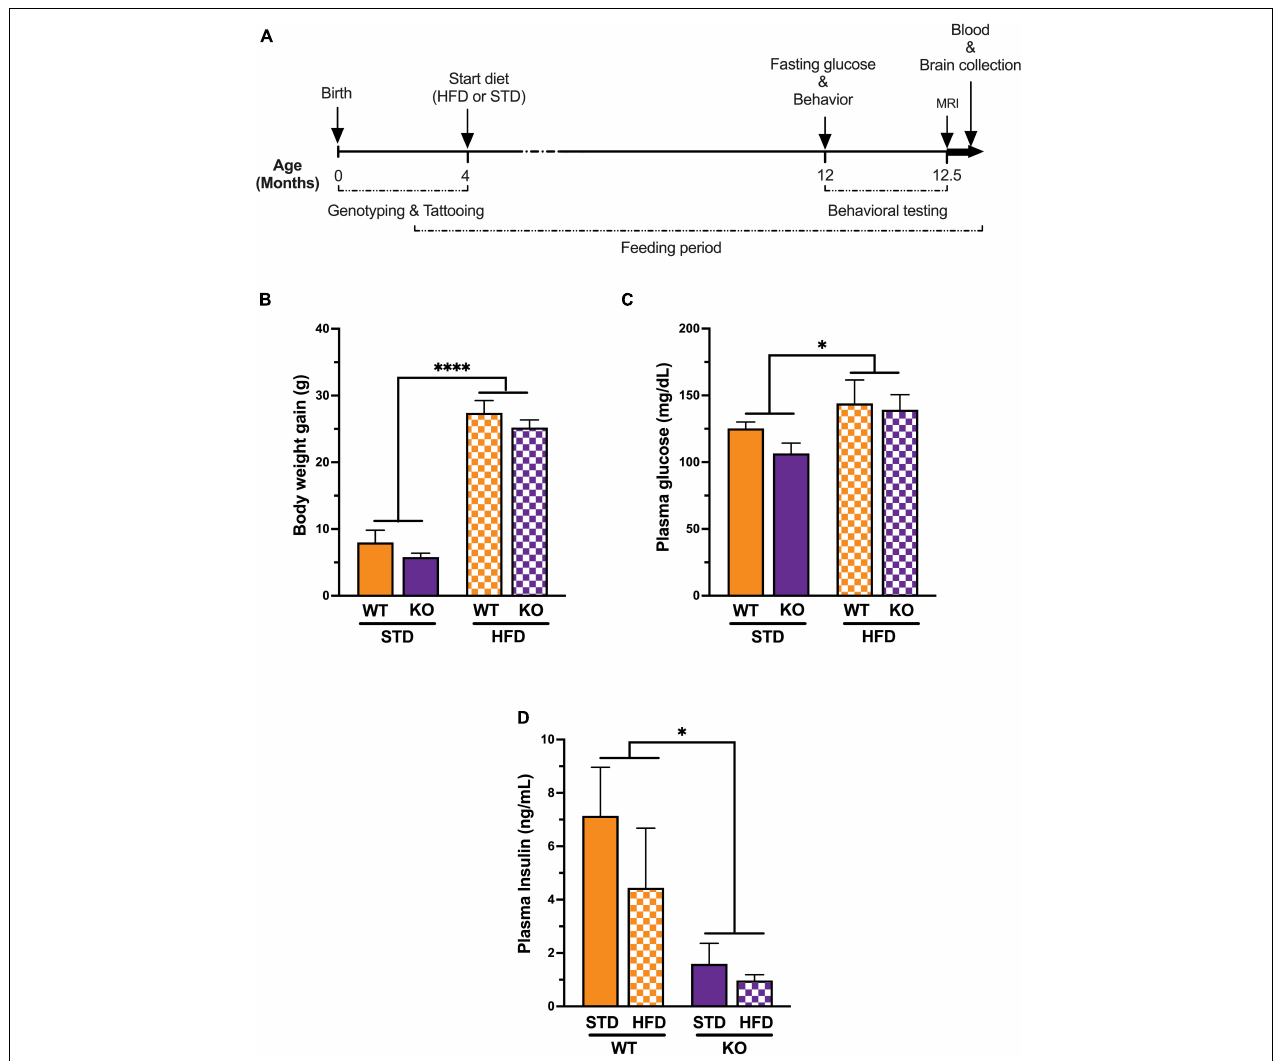
FIGURE 1 | Experimental timeline and Impact of high fat diet on metabolic syndrome. (A) All genotypes of mice were placed on a high fat diet or standard diet at 3–5 months of age. Behavioral and cognitive performance was assessed using the water maze and the novel object recognition tests. Fasting glucose was measured just before behavior and magnetic resonance imaging ( n = 6 per group, randomly selected) upon completion of the study. Plasma samples and brains were collected for biochemical assays and oxylipins analysis respectively. (B) Mice on a long-term high fat diet develop a diabetic phenotype. Prior to initiation of dietary intervention, there were no significant difference in body weight between groups. High fat diet caused a significant increase in body weight in both genotype after 8 months on the diet. (C) Plasma fasting glucose showed significant diet effect without genotype effect. (D) Plasma insulin levels showed significant genotype effect with low insulin in KO mice compared to WT littermates regardless of diet. All values represent means ± standard error of the mean, ∗ p < 0.05, ∗∗∗∗ p < 0.0001, n = 5–10 per